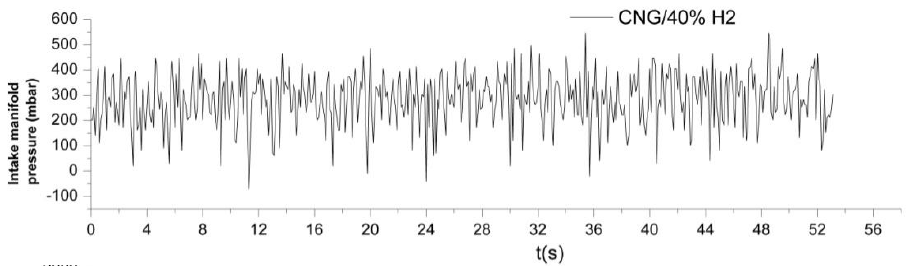
Figure 14. Intake manifold pressure profile for H 2 CNG40.